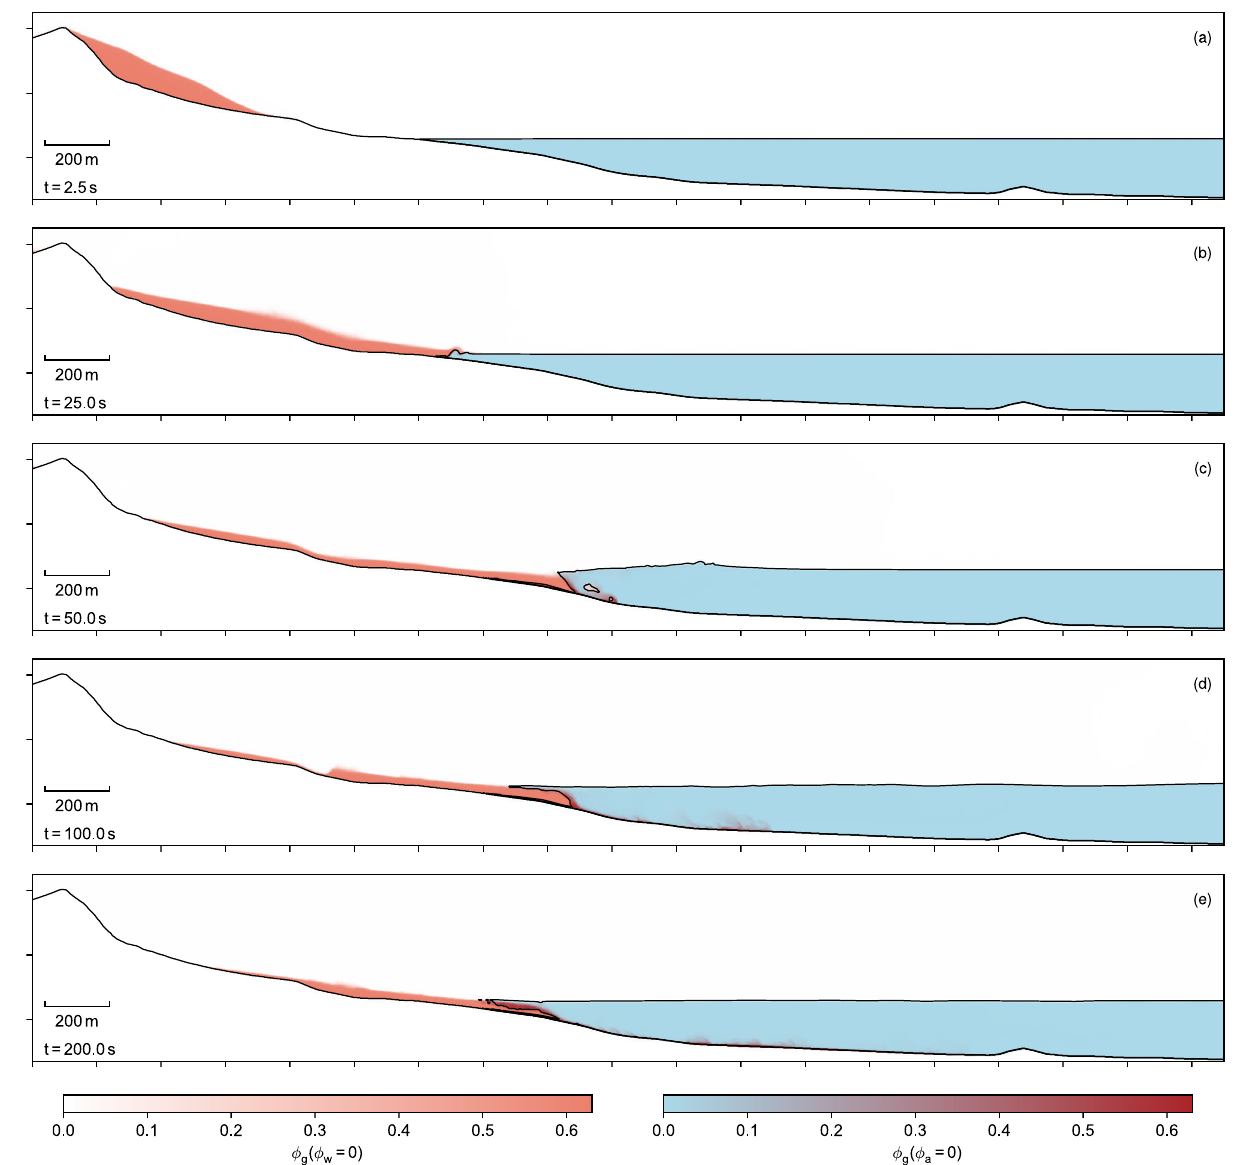
Fig. 7 Vertical slice through the Lake Askja landslide tsunami. a – e The colour represents the local phase fractions. The free water surface and the mesh boundary are highlighted as a black line. The left colour map indicates the limiting case of dry regions, the right colour map the limiting state of water- saturated regions. Few regions are partially saturated due the sharp interface between air and water. The total length of the transect is 3700 m and the axes are scaled equally. For an animated version see supplemented movie